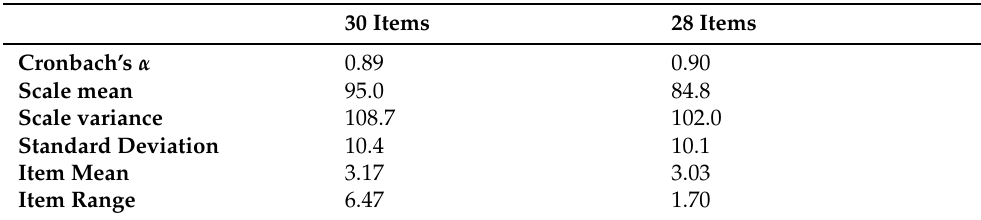
Table 3. Reliability assessment showing two calculations of Cronbach’s α for N = 153. The second calculation excludes the two items “The horse is visibly lame at walk” and “The horse is closely bonded with a companion”.